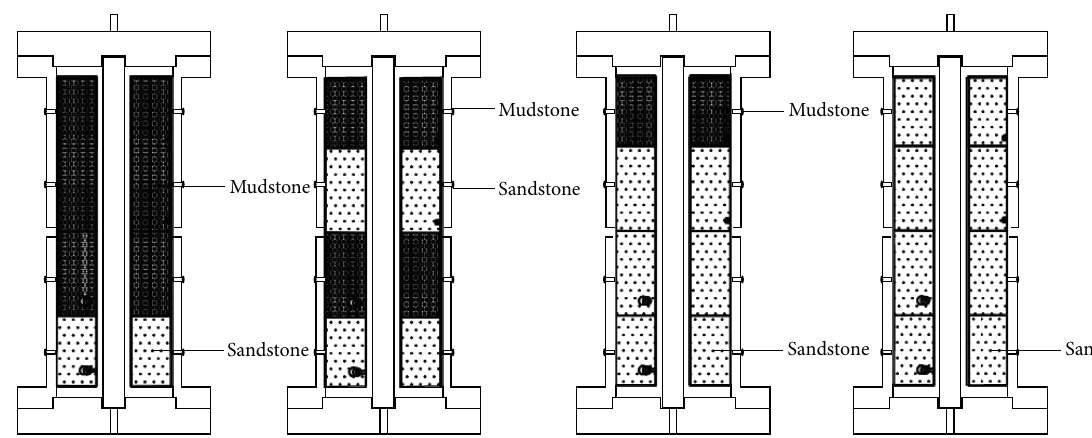
Figure 1: Schematic diagram of ISMR simulation.